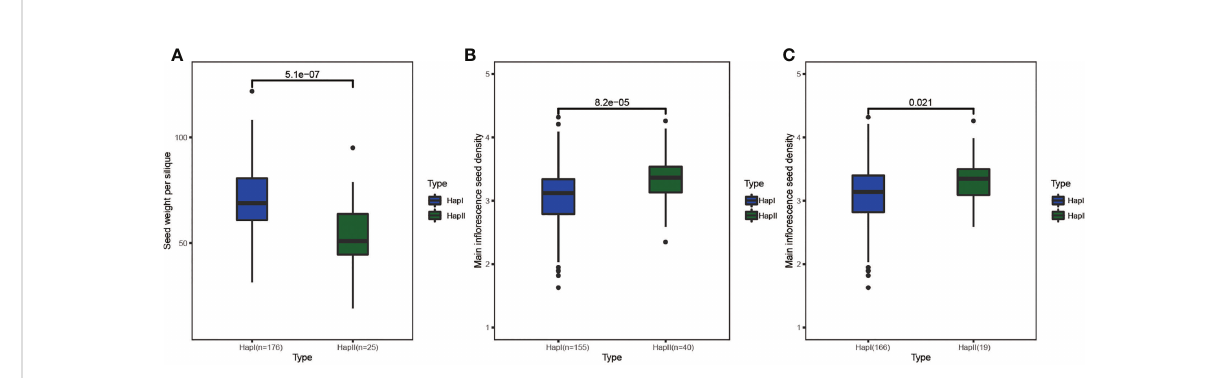
FIGURE 8 The haplotype analysis of BnCLE s for seed weight per silique and main in fl orescence seed density. (A) BnaC.CLV3.a . (B) BnaA.CLE20.b . (C) BnaC.CLE20.b